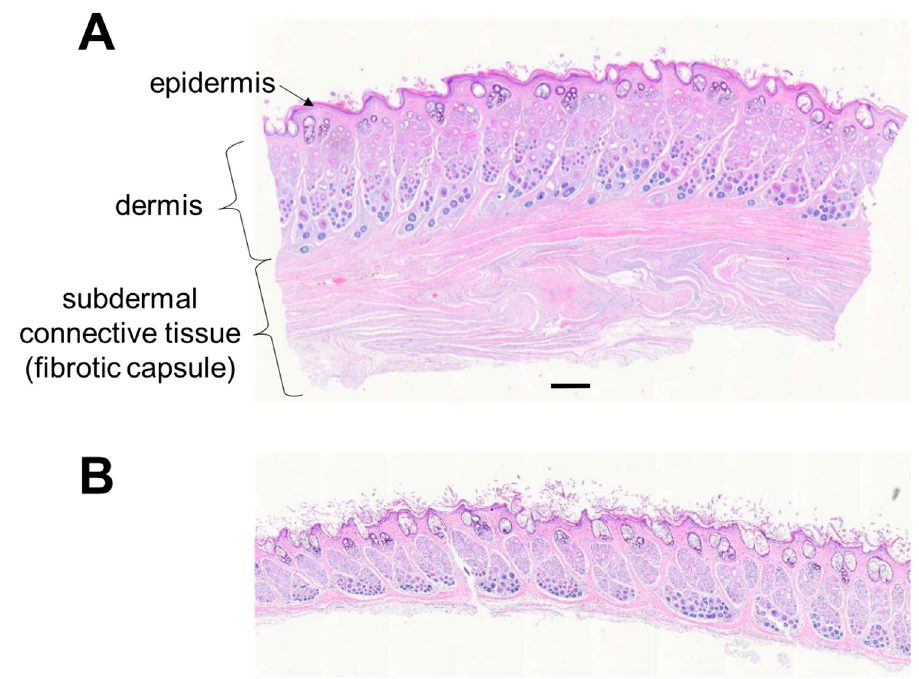
Figure 6. Histology of tissues (rabbit E2) from the ventral aspect of ( A ) the endoprosthetic foot in the operated limb and ( B ) the biological foot in the non-operated limb. Bar = 0.64 mm.